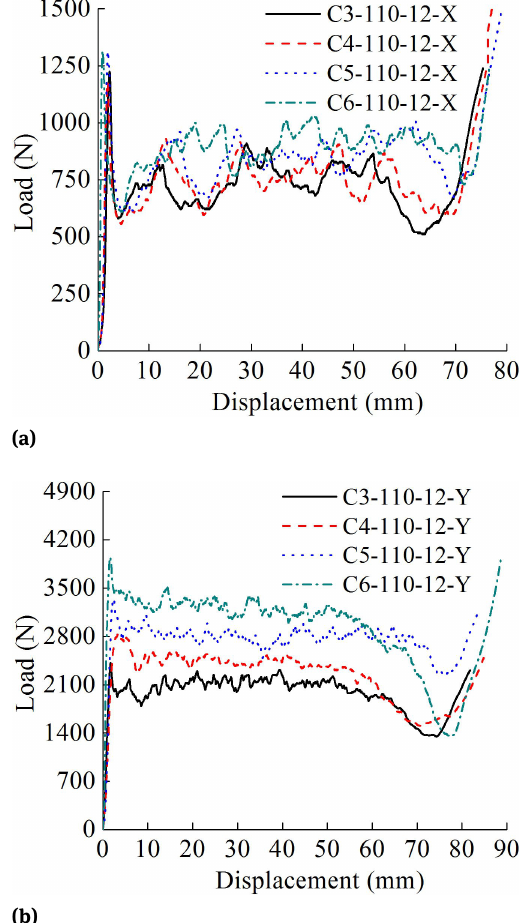
Figure 10: Load and displacement curves with different cross- sectional shapes: (a) tubes along X direction; (b) tubes along Y